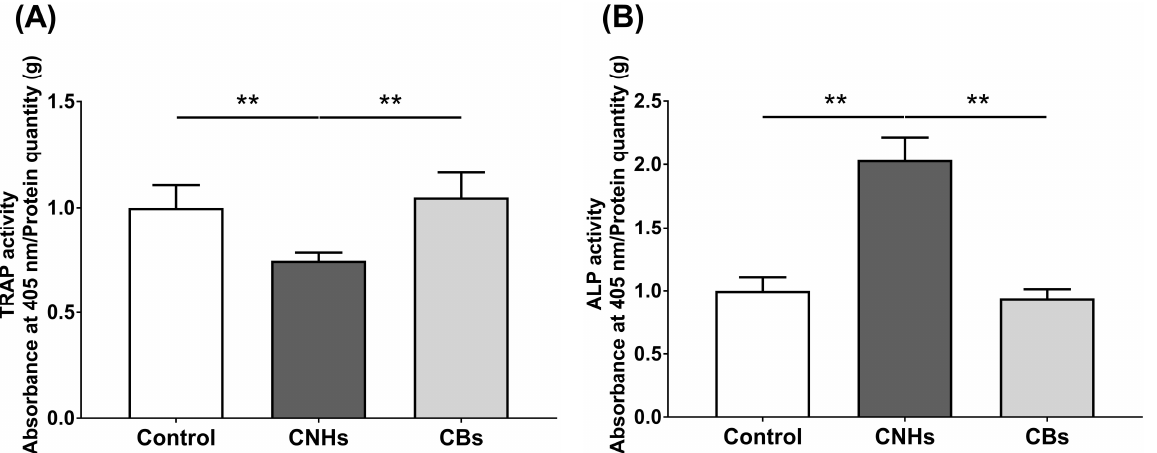
Figure 4. TRAP/ALP activity of CNMs exposed to OCs and OBs. ( A ) TRAP activity of OCs exposed to CNHs and CBs. n = 8 cultures. ( B ) ALP activity of OBs exposed to CNHs and CBs. n = 8 cultures. Data are represented as mean ± SD. Statistical significance was evaluated using the Tukey–Kramer test. ** p < 0.01.